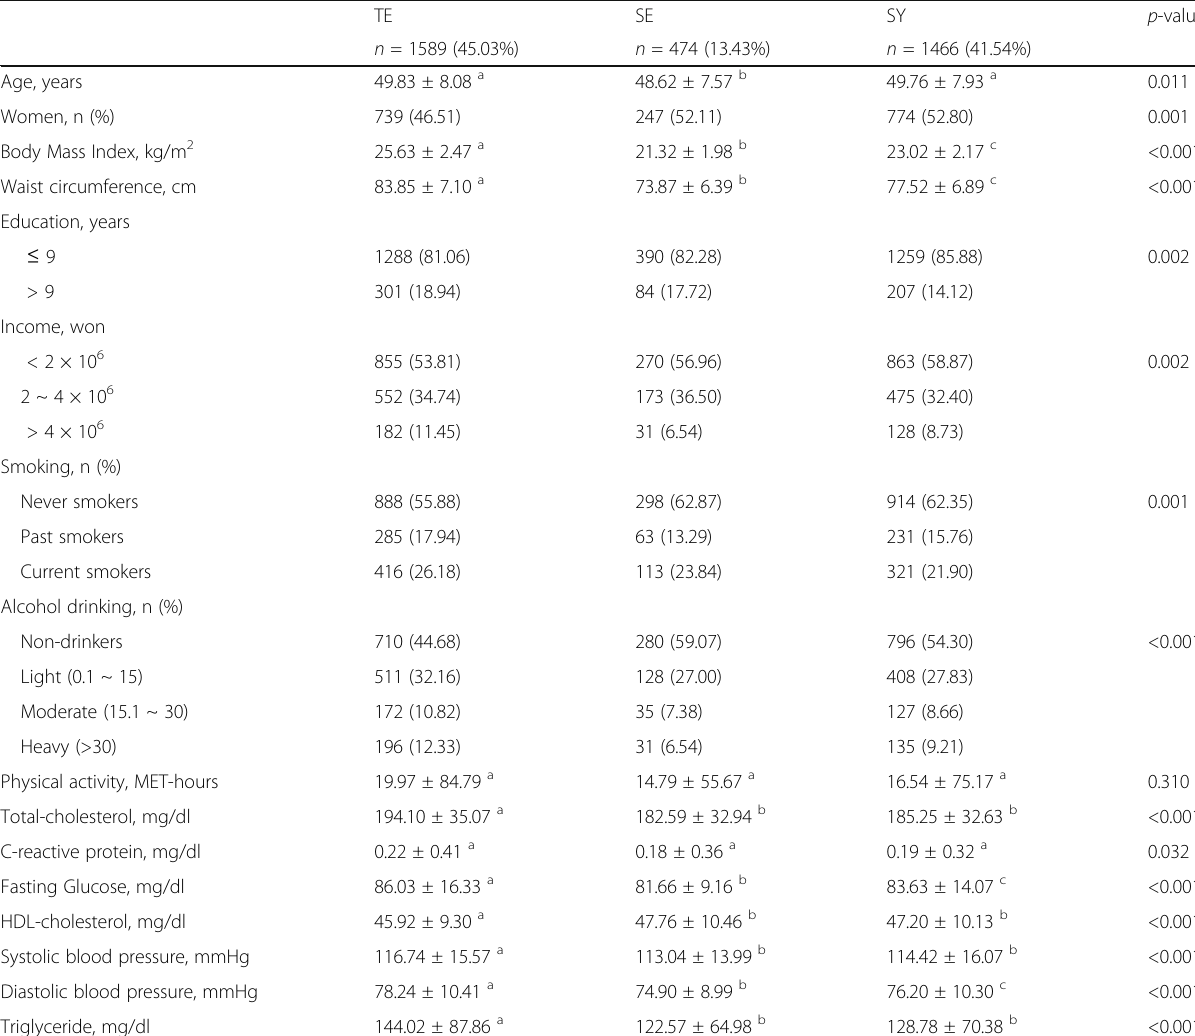
Table 1 General Characteristics of the Study Participants ( n = 3529) TE